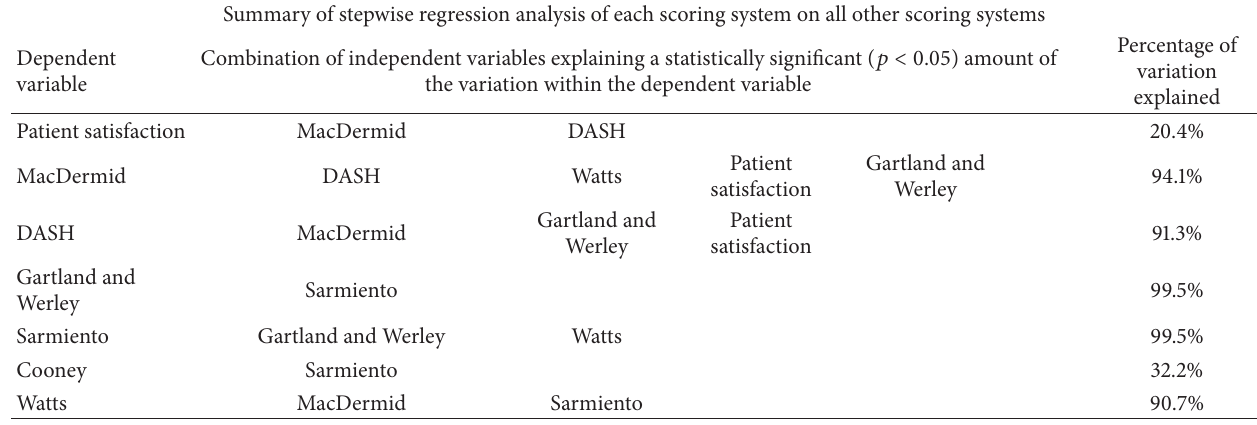
Table 4: Summary of stepwise regression analysis of each scoring system on all other scoring systems.